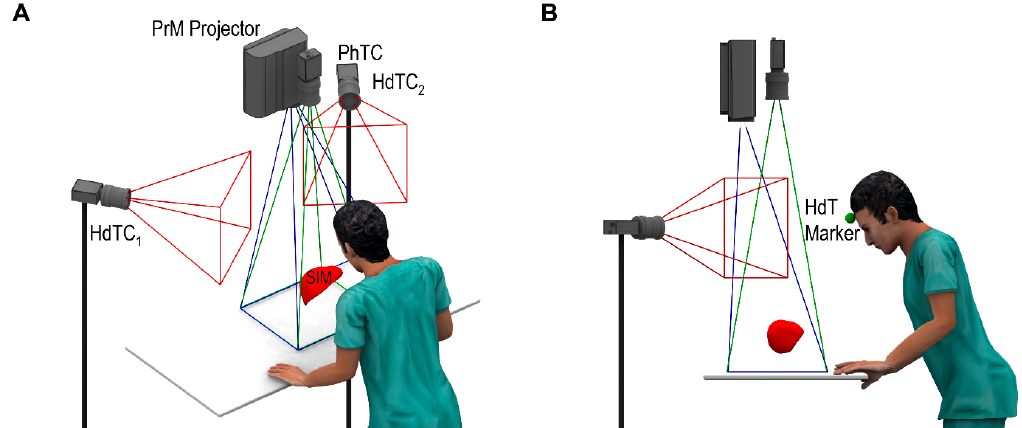
Figure 5. MARVIS system setup from a perspective view ( A ) and from its left side ( B ). HdTC 1 and HdTC 2 are the head-tracking cameras, and PhTC is the phantom-tracking